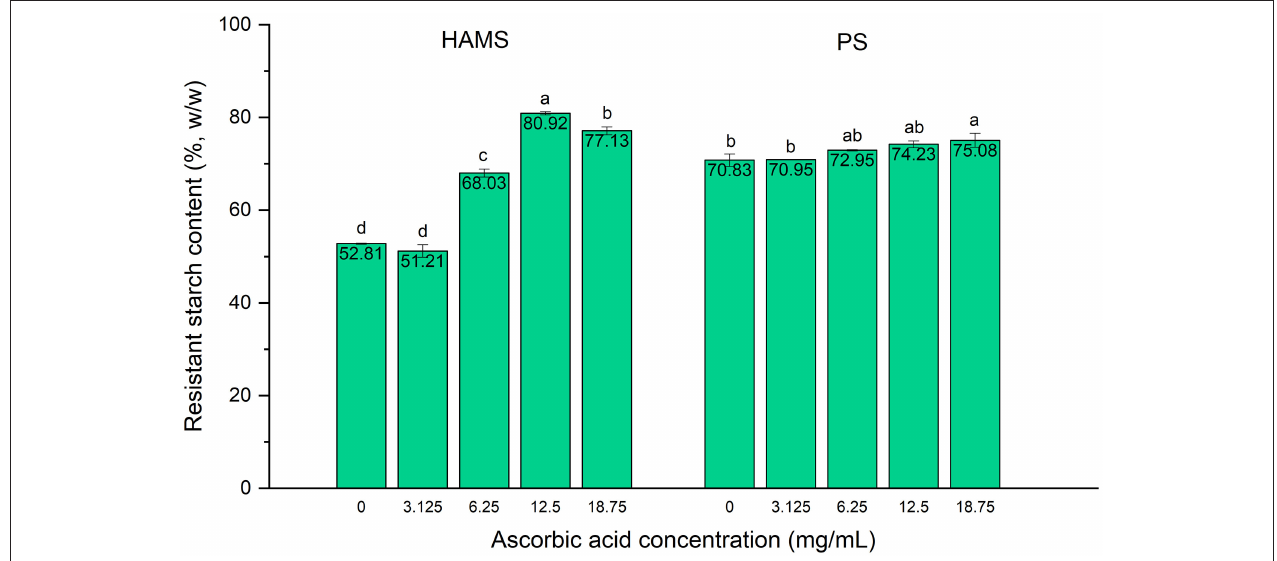
FIGURE 1 | Resistant starch contents in high amylose maize starch (HAMS) and potato starch (PS), presented as a proportion of total starch, with the presence of ascorbic acid at various concentrations. Error bars show standard deviation; n = 2. Significant differences among treatments of differing ascorbic acid concentrations are denoted by different letters (a > b > c > d, p <